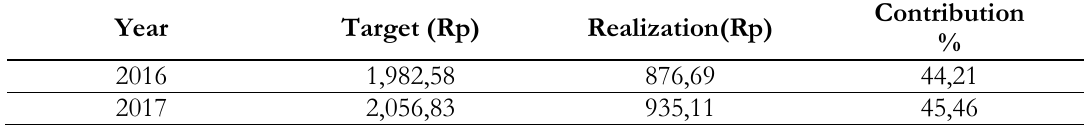
PKB Contribution to PAD of Bekasi City 2016-2017 (Billion